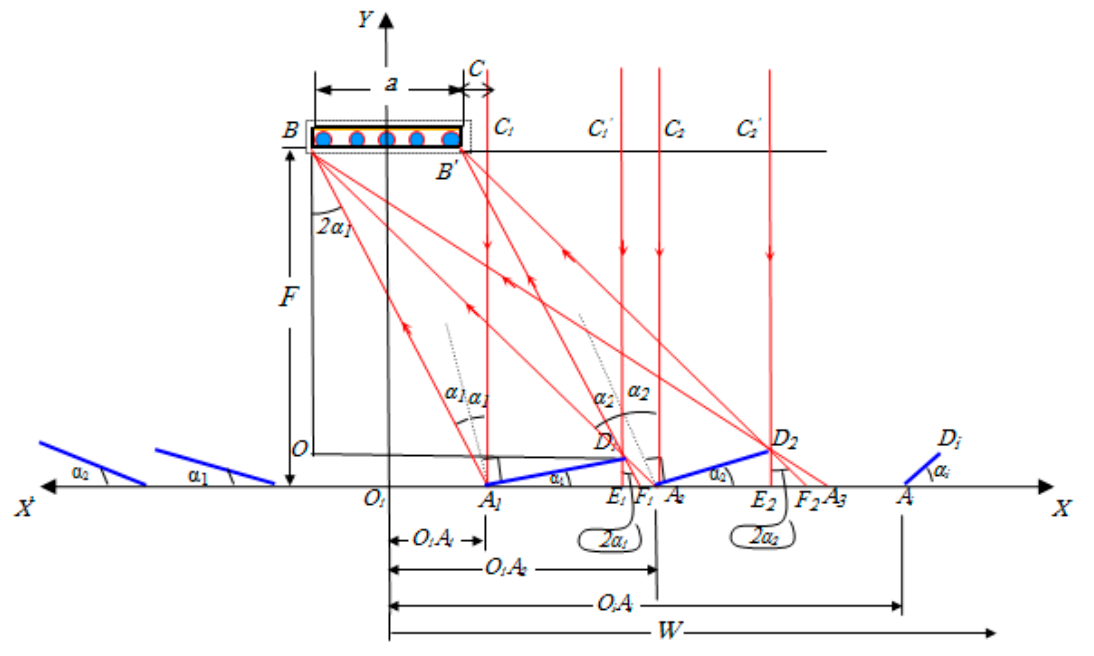
Figure 1. Structure of LFMR solar concentrator.